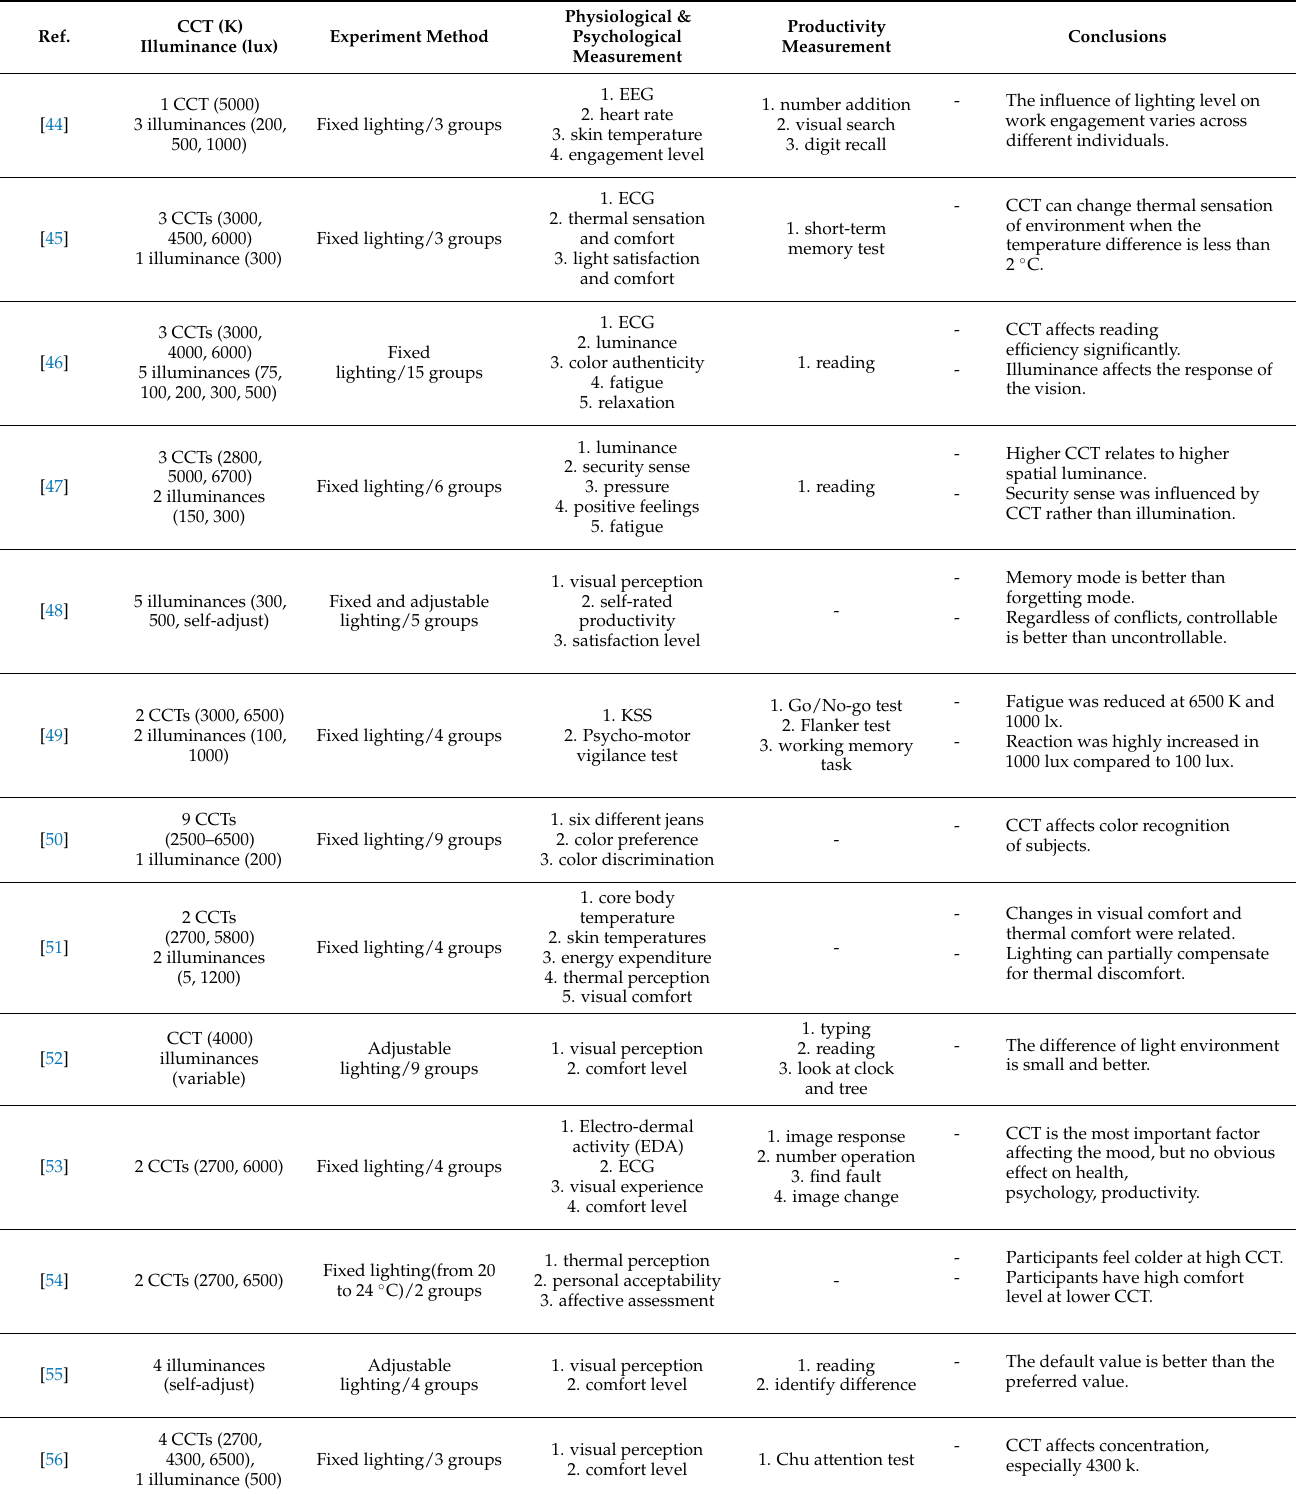
Table 1. Representative experiments in lighting research